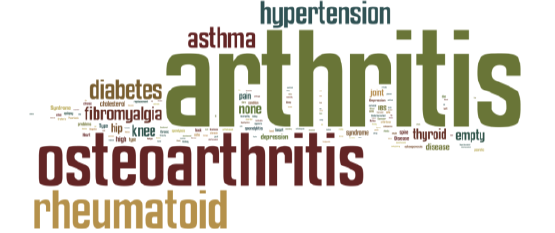
Figure 3. Medical conditions participants suffered from. The word cloud provides a graphical representation of frequency of words.